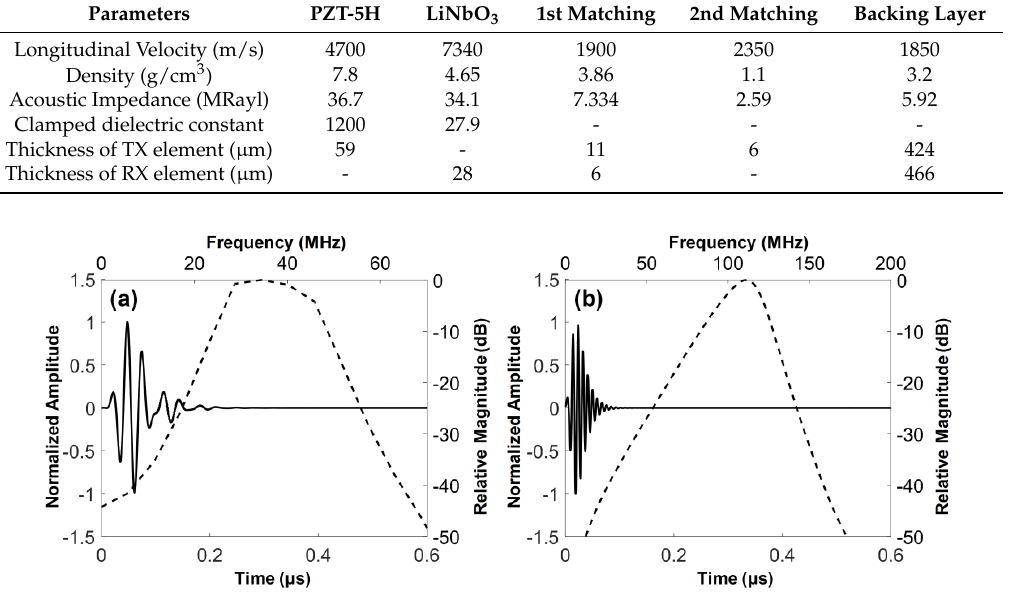
Figure 4. Simulated pulse-echo responses (solid line) and their frequency spectra (dashed line): ( a ) 35- MHz and ( b ) 105-MHz elements of the dual-element focused transducer.